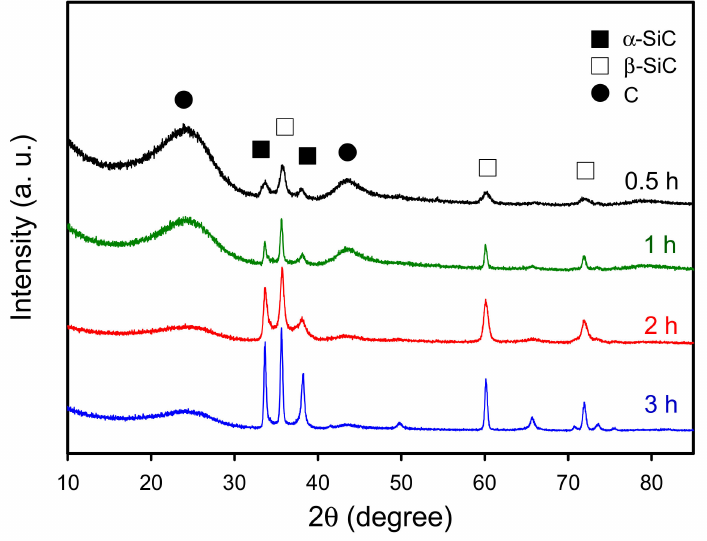
Figure 4. XRD patterns of BcSiCs sintered at 1700 ◦ C for di ff erent